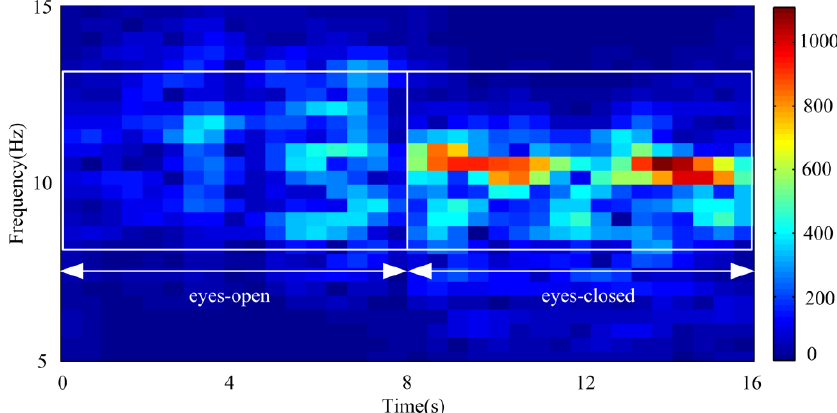
Figure 12. Spectrogram of the extracted alpha rhythm under eyes-open and eye-closed conditions by L = 40.